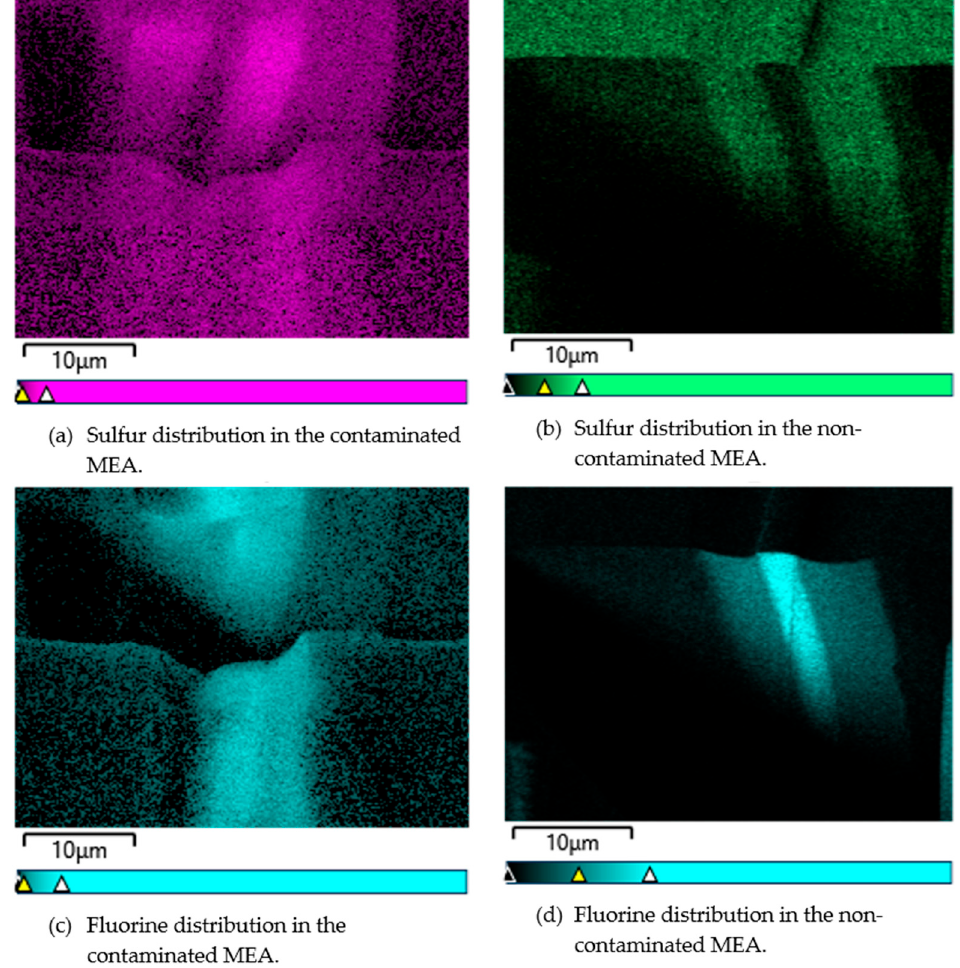
Figure 5. The distribution of sulfur and fluorine in both contaminated and non-contaminated (4 ppm of CeO 2 ) samples using EDX analysis.